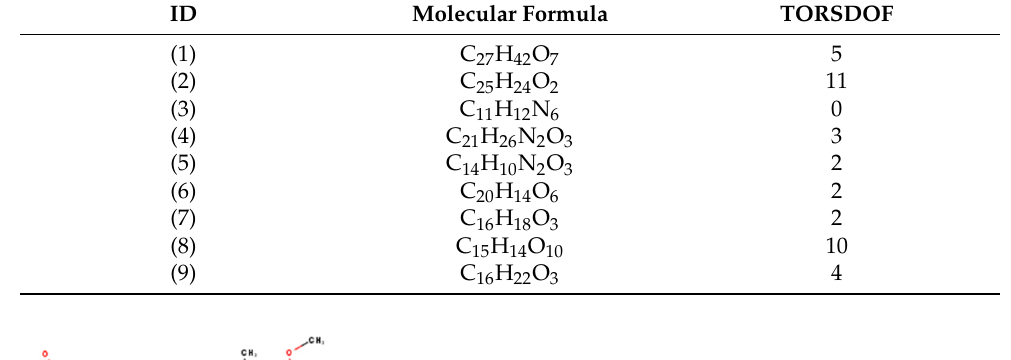
Table 3. Presentation of the dataset of the nine ligands used in this study with associated molecular formula and TORSDOF. This last parameter represents the intrinsic flexibility of the ligands as considered within the docking process of AutoDock.